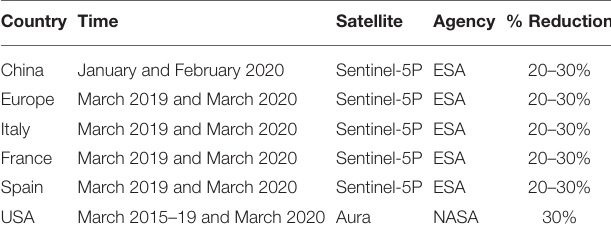
TABLE 1 | Assessment of air pollution during the coronavirus disease 2019 (COVID